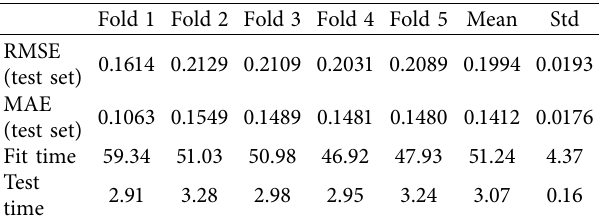
Table 2: Evaluating RMSE and MAE of algorithm SVD on 5 splits after parameter